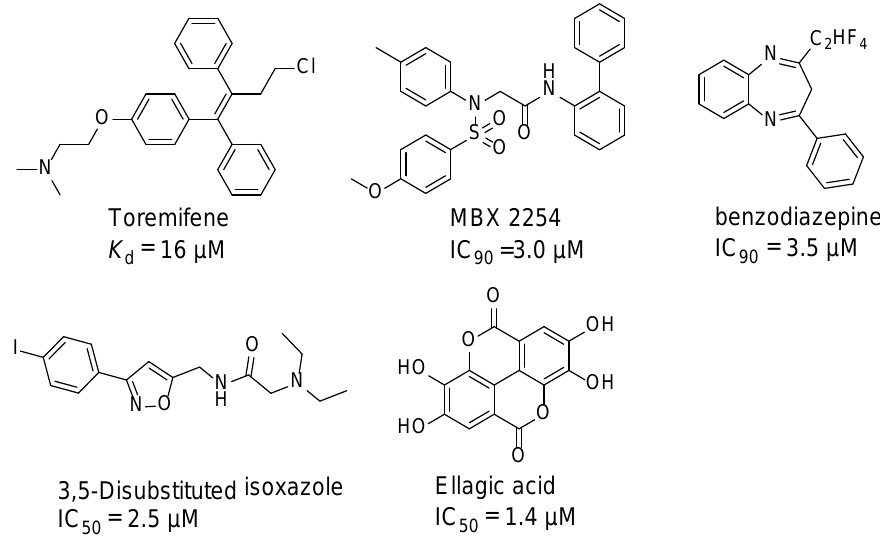
Figure 1. Small molecule inhibitors targeting Ebola glycoprotein.